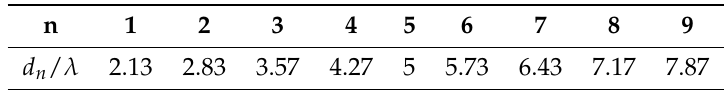
Table 7. Locations for the reweighted off-broadside design example, θ M = 10 ◦